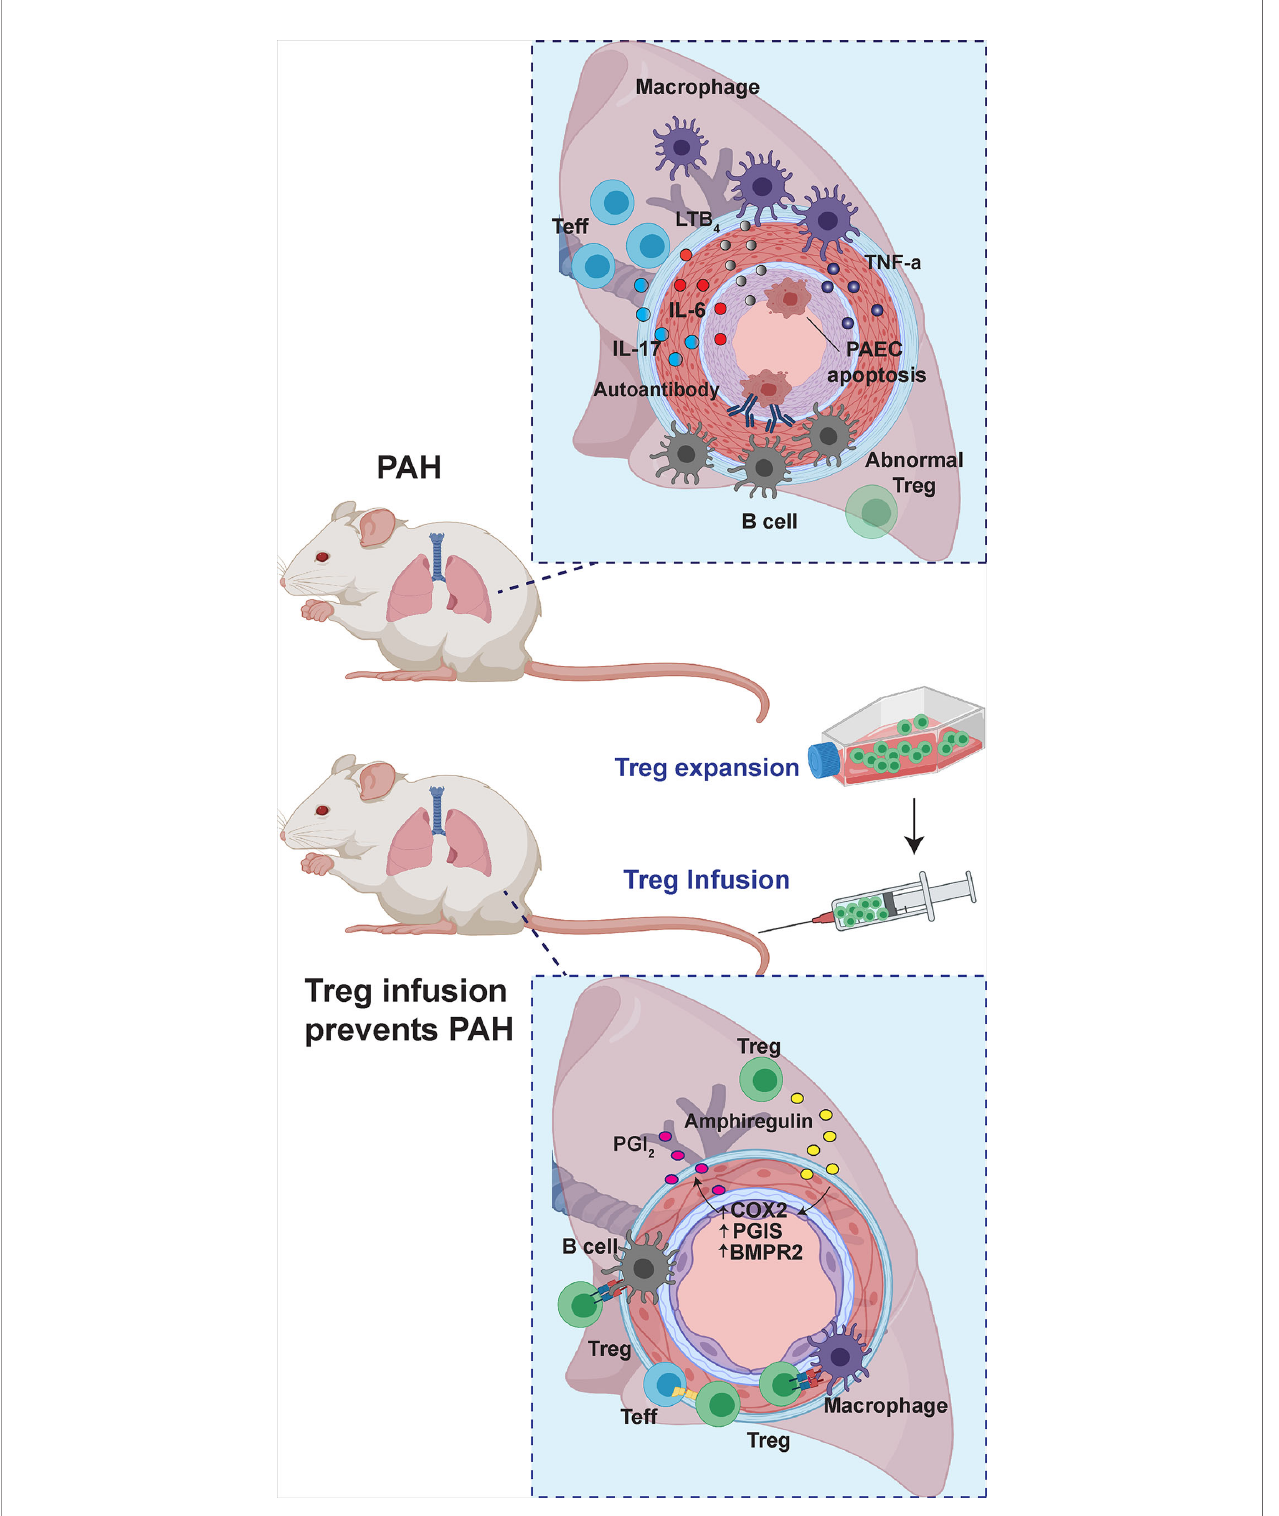
FIGURE 2 | The role of Tregs in PAH. In Treg-de fi cient rats, vascular injury culminates in enhanced B cell and macrophage-dominated in fl ammation. With Treg infusion before the induction of vascular injury, PAH is avoided through upregulation of anti-in fl ammatory and vasoprotective pathways, which include upregulation of COX2, PGIS, and